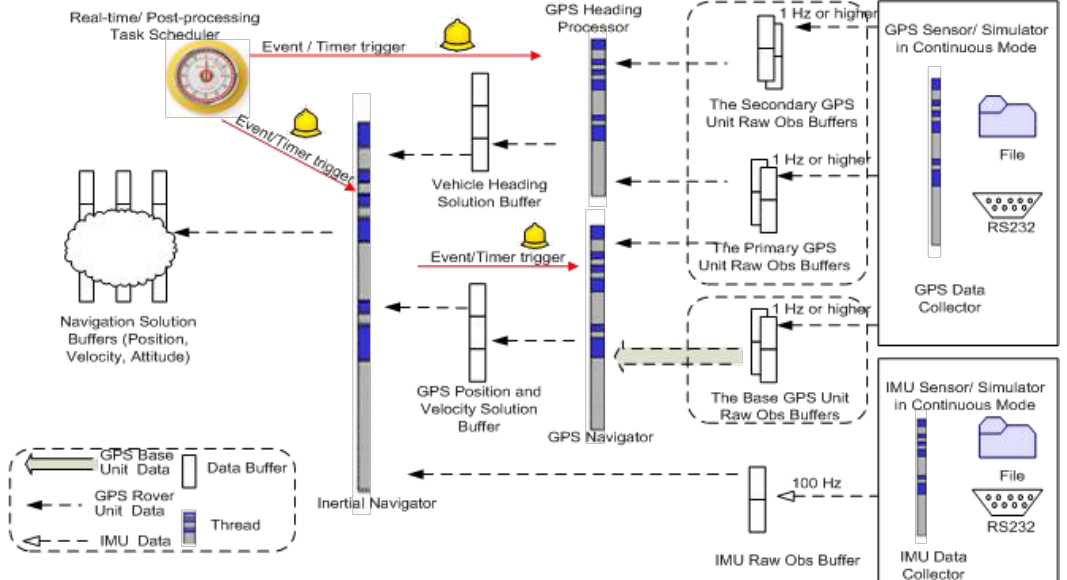
Figure 3. Software architecture of navigation